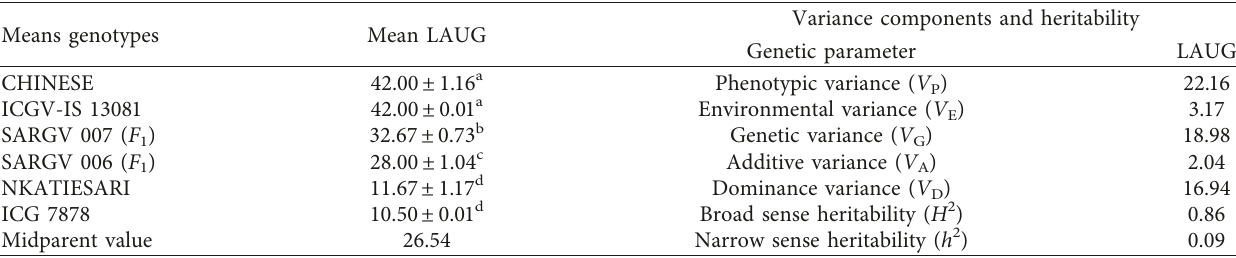
Means followed by same letters are not statistically Table 9: Proportion of stay-green classes (segregation ratios) at F